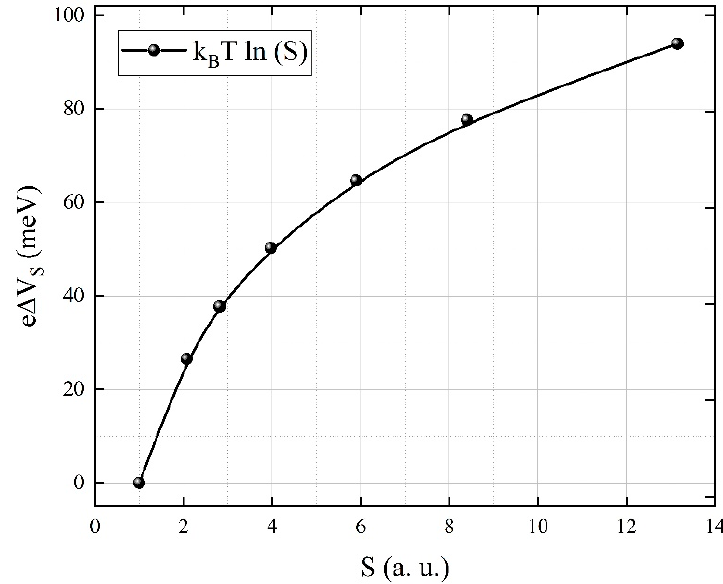
Figure 13. The changes in band bending depending on the sensor signal.